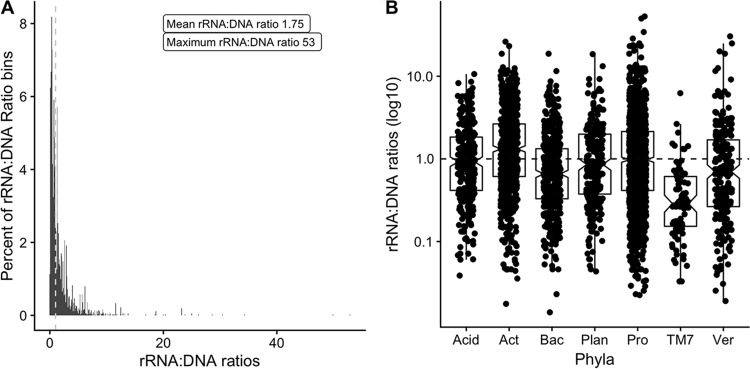
rRNA/DNA ratios in empirical sequence data. (A) Histogram of the ratios of OTUs from forest floor sequence libraries. Ratios were calculated individually for every OTU from 12 paired replicate sequence libraries. (B) Relationship between rRNA/DNA ratios and taxonomy. Each point represents an individual OTU. Only phyla that were present across all of the sequence libraries and accounted for >5% of the sequences are displayed. Given the large range of rRNA/DNA ratios, the y axis is displayed as a log scale. The dashed line represents an rRNA/DNA ratio of 1. OTUs above the line would be classified as active, and those below the line would be classified as dormant. The boxes denote the interquartile range of the rRNA/DNA ratios, with the notch denoting the mean. Phylum abbreviations: Acid, Acidobacteria; Act, Actinobacteria; Bac, Bacteroidetes; Plan, Planctomycetes; Pro, Proteobacteria; Ver, Verrucomicrobia.